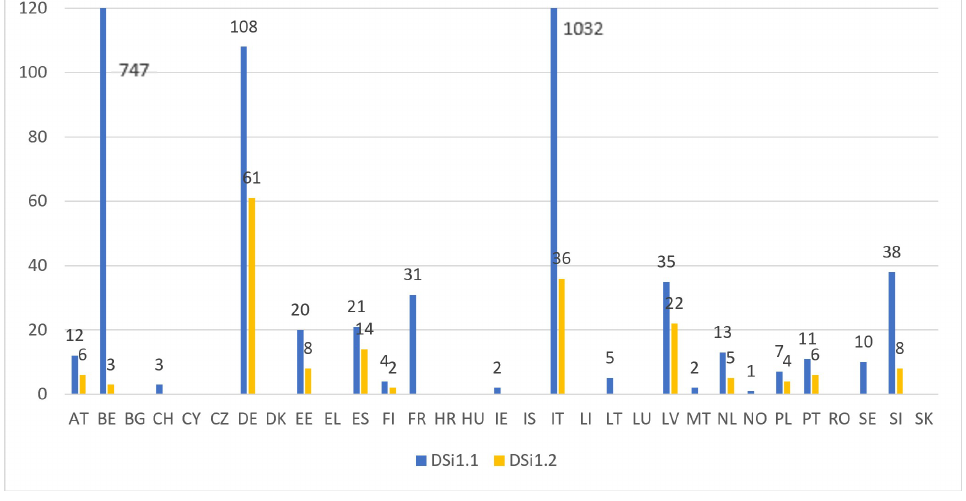
Figure 12. Indicators DSi1.1 and DSi1.2 for hydrogeology.